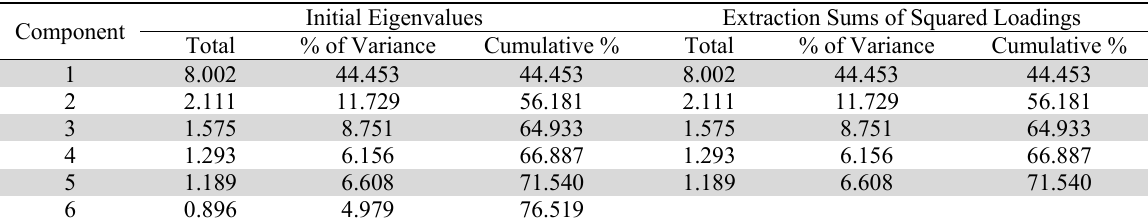
The results of total variation of the data Component